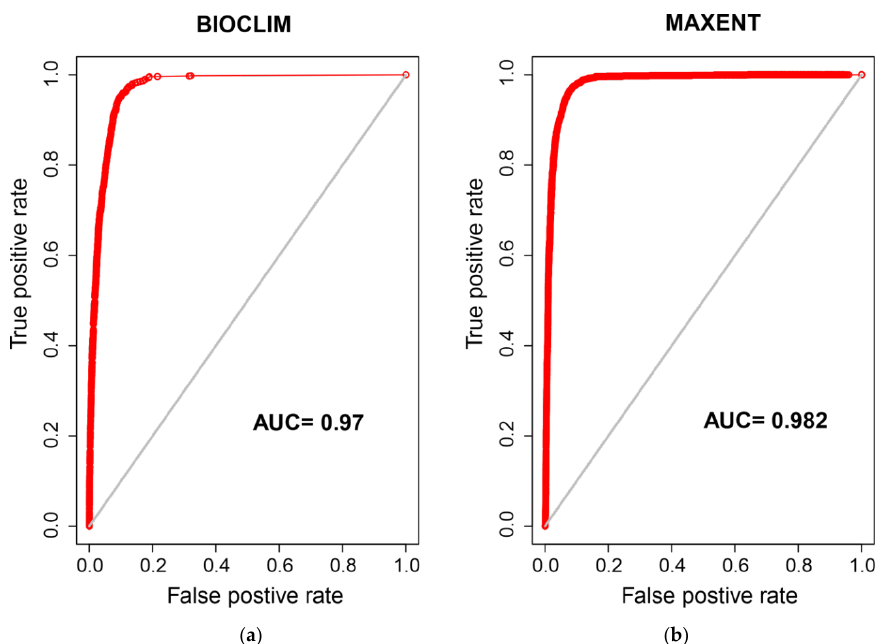
Figure 4. Area under the receiver operating characteristic curve (AUC) plots for BIOCLIM prediction ( a ) and MAXENT prediction ( b ). This value is a number between zero and one and represents how accurately a model predicts presence/absence. A model with an AUC value of 1 predicts presence/absence with 100% accuracy while a model with an AUC score of 0.5 is one that predicts presence or absence correctly 50% of the time [30].